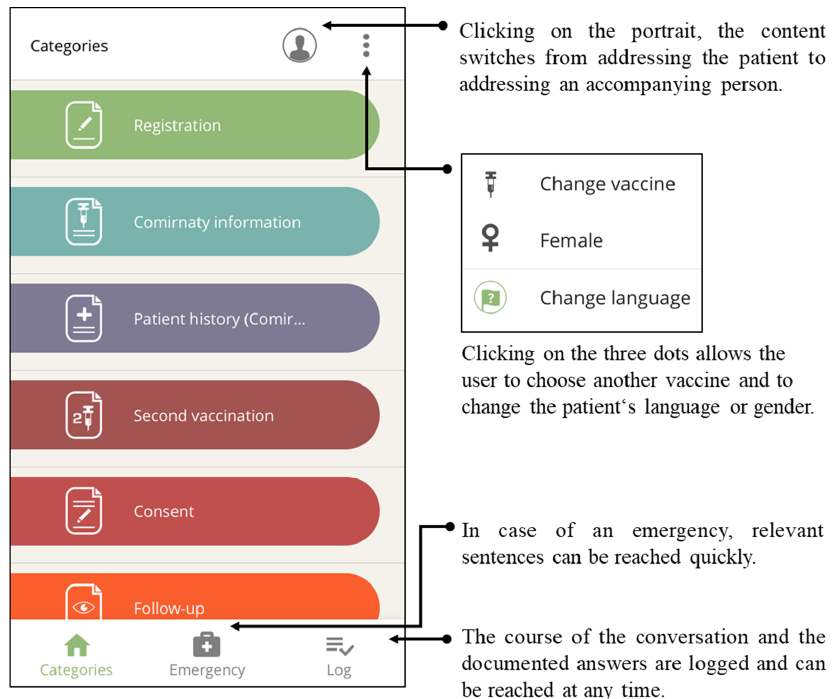
Figure 2. The content is grouped into categories with recognizable icons. The user interfaces allow changes in addressee, administered vaccines, chosen language, and the vaccination candidate’s gender at any time.